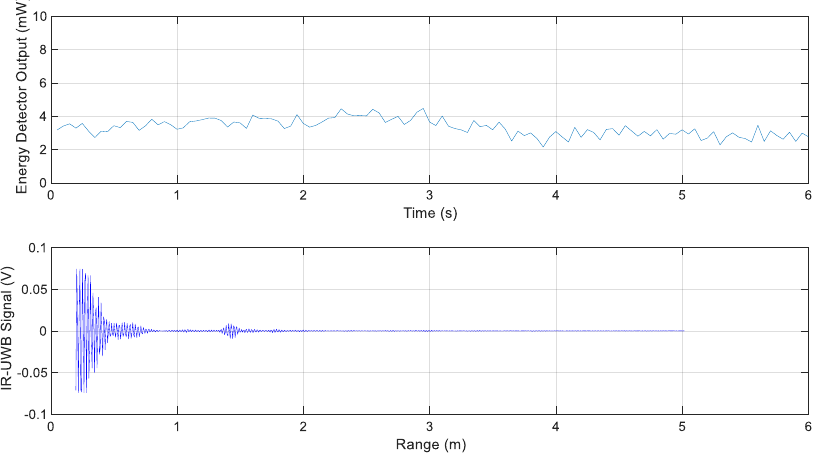
Figure 8. Energy detector output and IR-UWB signal for Scenario 1.